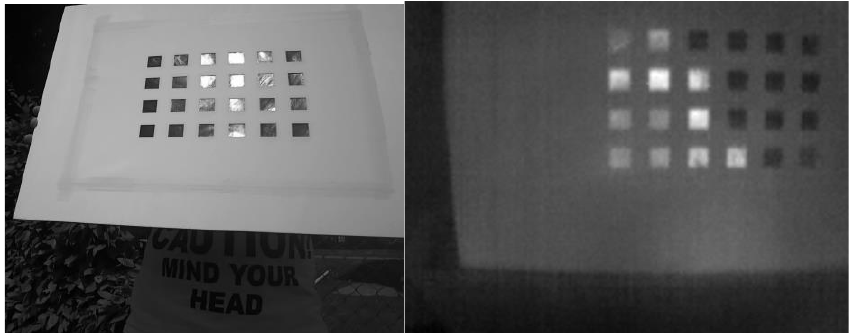
Figure 5. The reflections affecting the target, in the visible (left) and in the thermal bands (right).